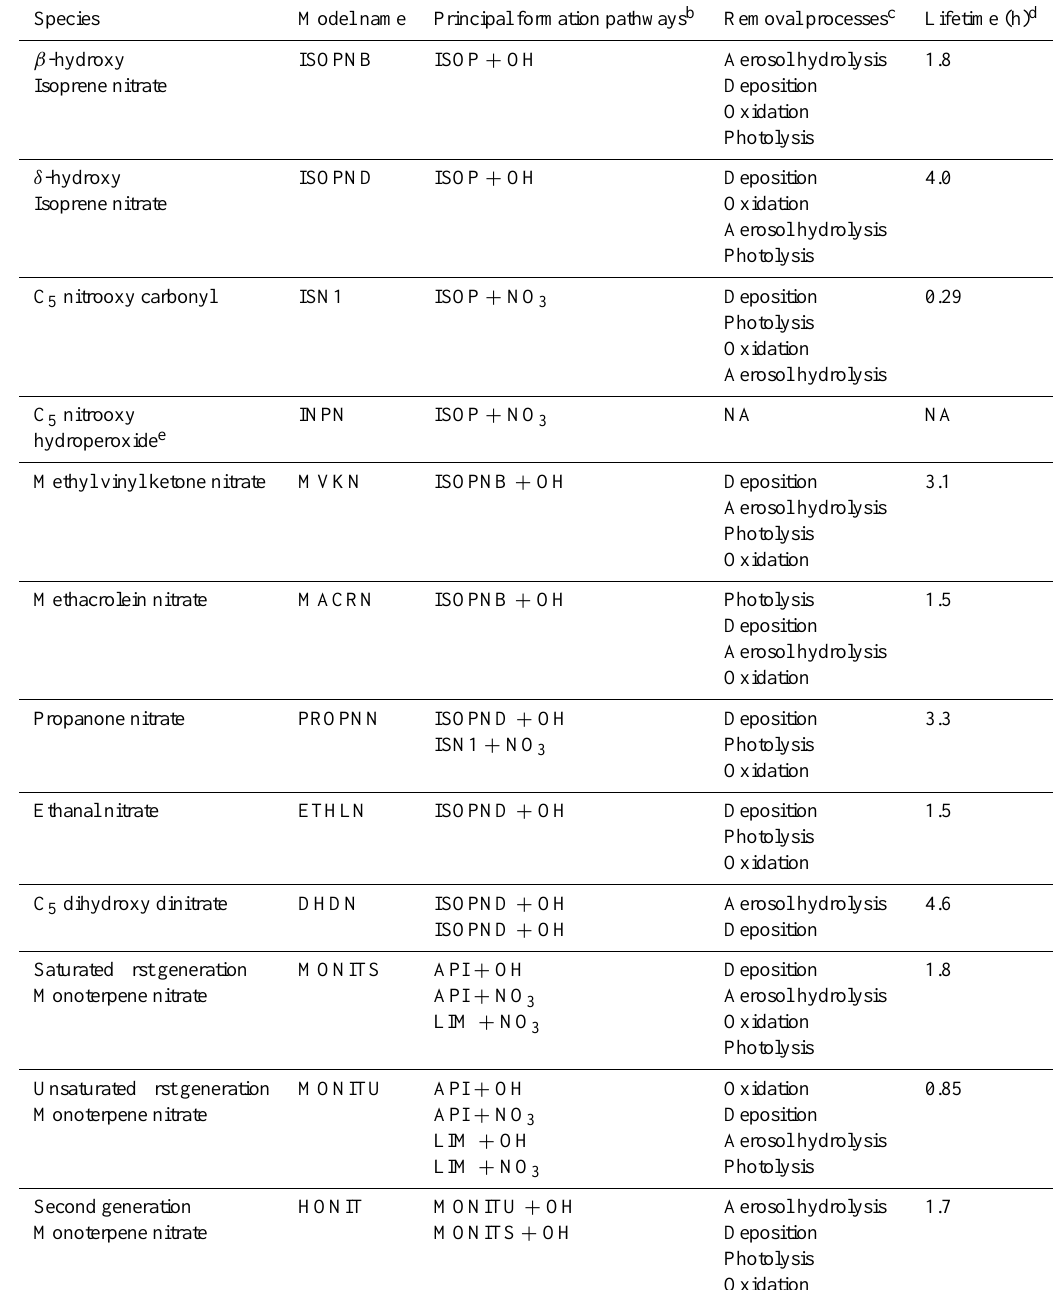
Table 1. Gas-phase organic nitrates in GEOS-Chem: formation and loss pathways and lifetimes. a